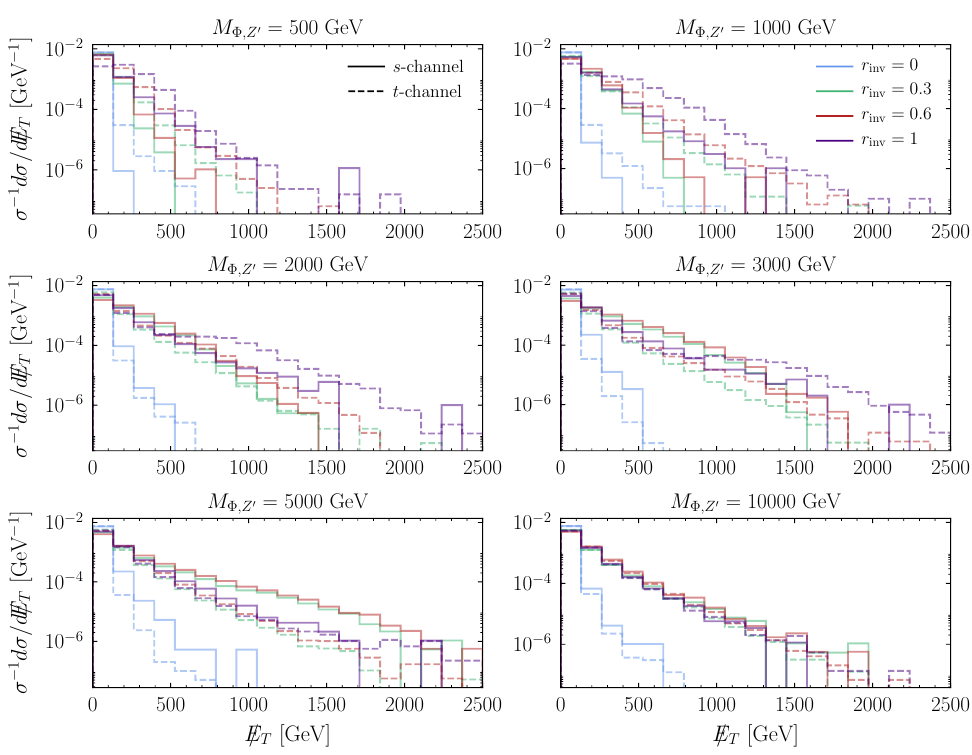
Figure 12 . (cid:30) E T distributions for the s - and t -channel models for a range of mediator masses and r inv